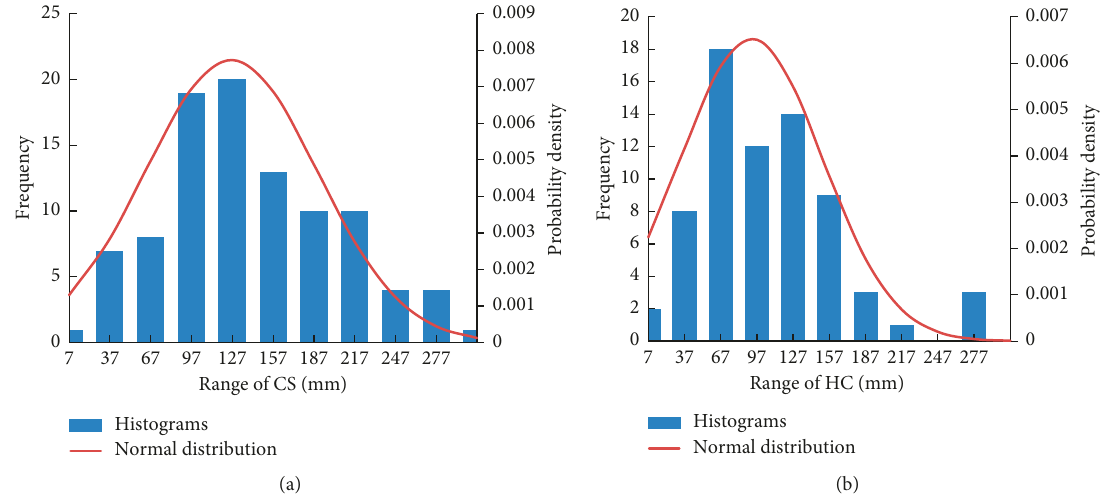
Figure 13: Histograms of tunnel deformation and normal distribution